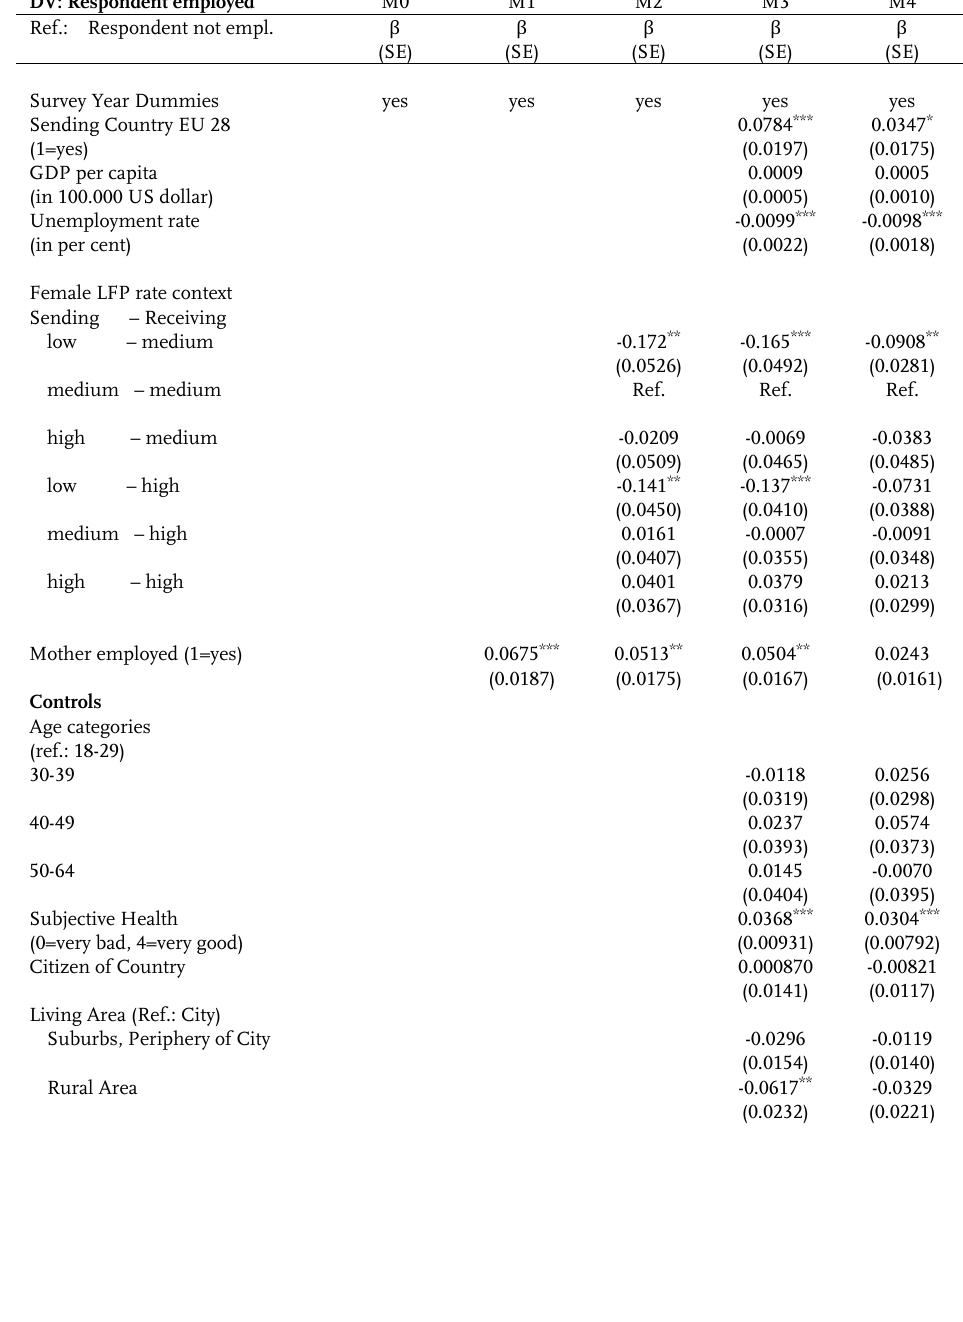
Table A.8 : Linear multilevel probability models for female immigrants’ employment (M1, M2 &